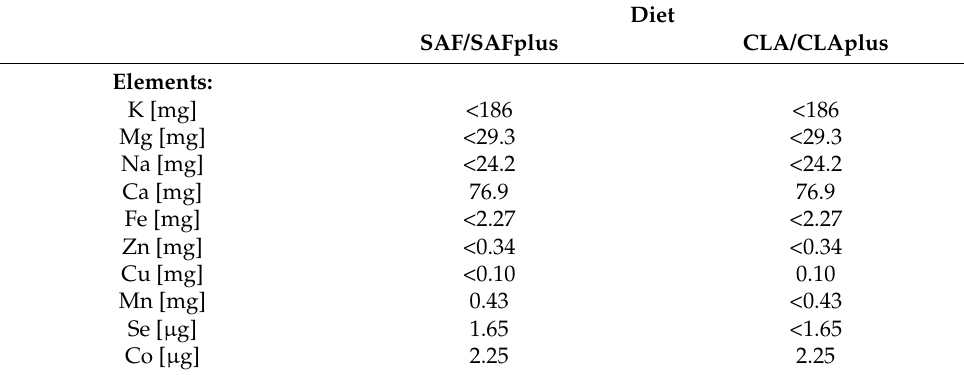
Table 1. Daily intake of dietary